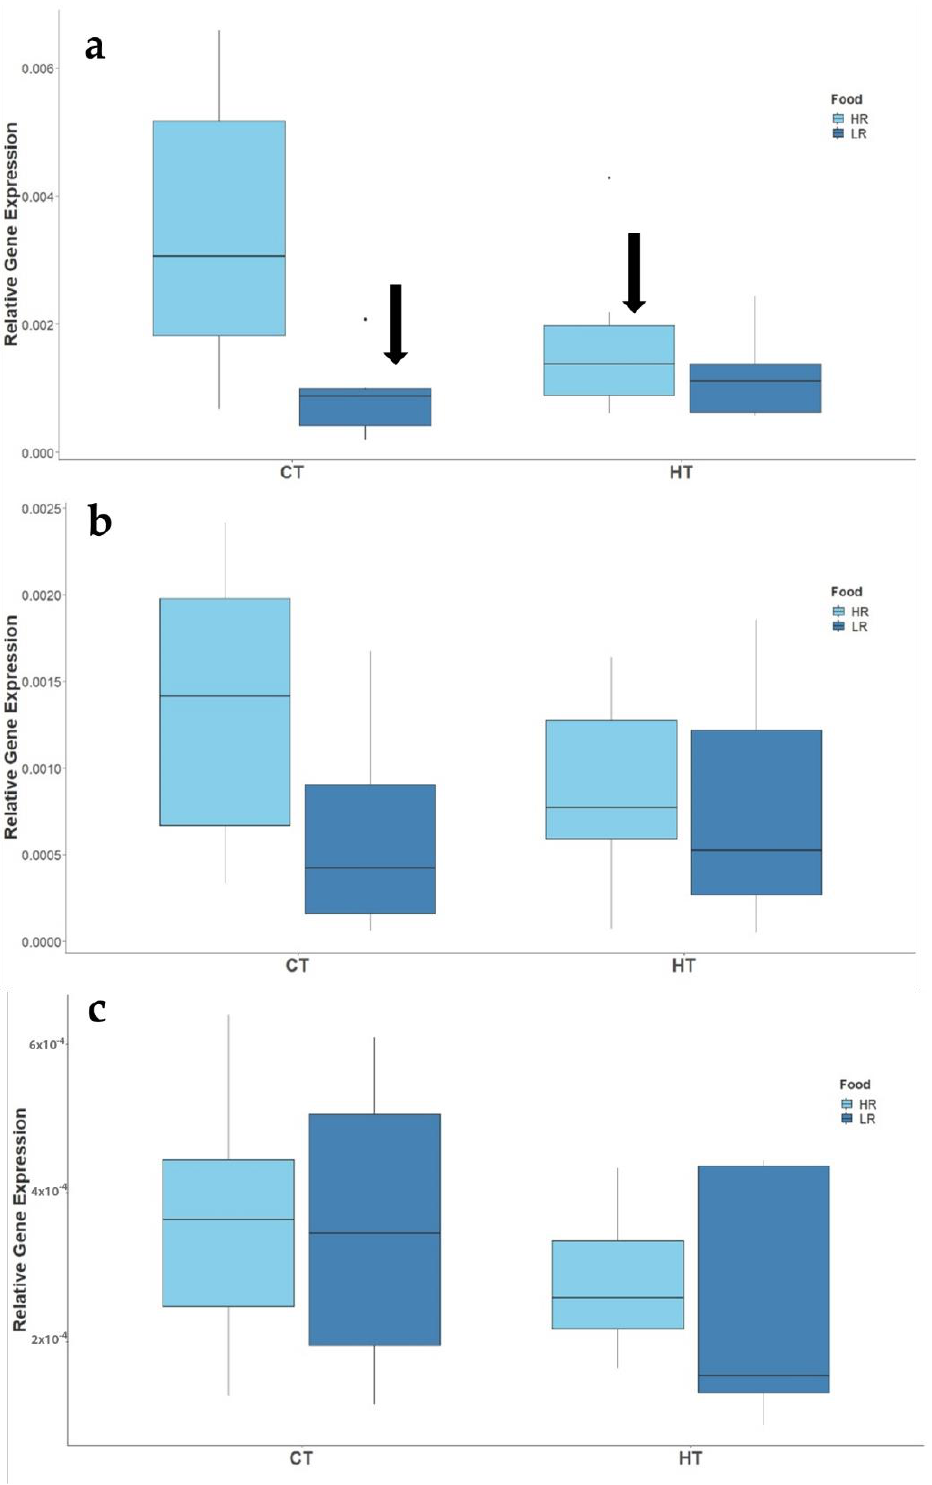
Figure 4. Effect of temperature (CT and HT) and food availability (HR, LR) on the expression of gonadal steroidogenic enzymes cyp11b1 ( a ); cyp19a1 ( b ); 20 β -hsd ( c ) of two-spotted goby, Pomatochistus flavescens . Black arrows indicate significant treatment effects ( p ≤ 0.05) as compared to CT + HR treatment.